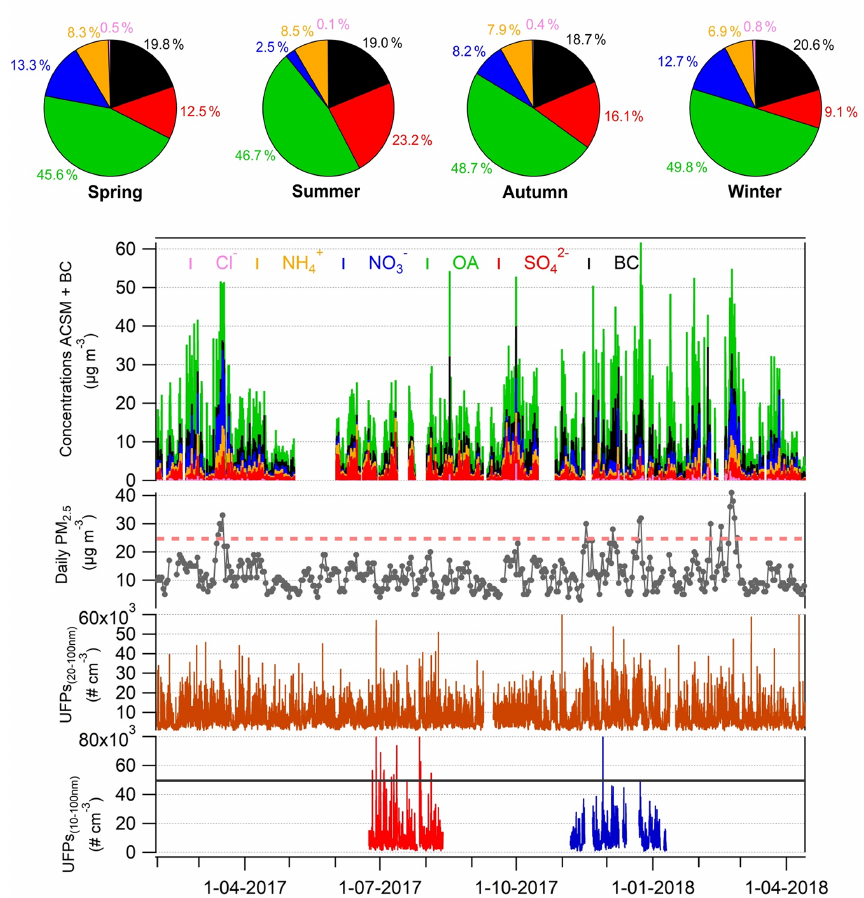
Figure 3. Time series of 1h PM 1 chemical species (Cl − , OA, NH + with 3031 and total UFPs (10–100nm) measured with SMPS GRIMM (summer period in red and winter period in blue) from 1 February 2017 to 13 April 2018. The average particle number concentrations were higher in winter; however, sharp events exceeding 50000cm − 3 (black line) were more abundant in the summer period. This feature is traceable for the 10–100nm size range measured with the SMPS GRIMM. The pink dotted thresholds correspond to the daily PM 2 . 5 concentrations recommended by the WHO. Pie charts of the average PM 1 component contribution for each season are shown in the upper